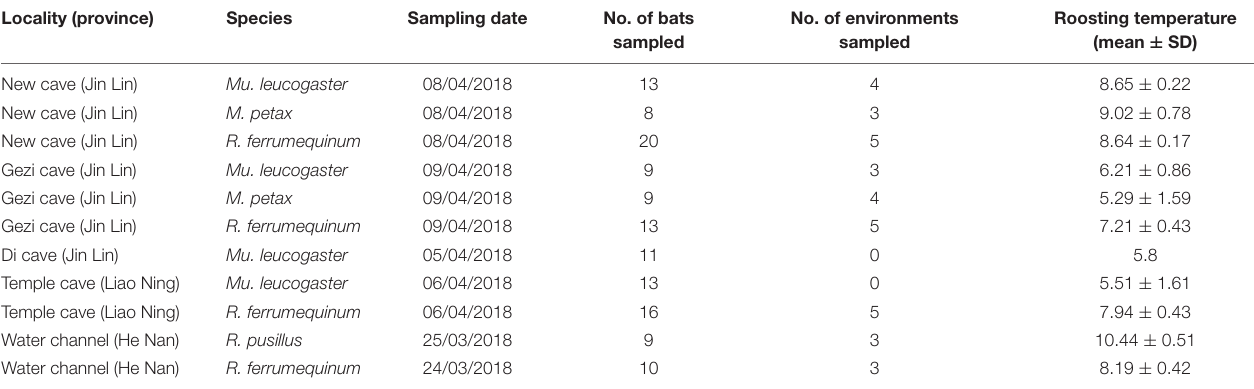
TABLE 1 | Summary of host species, site, and sample sizes information. Locality (province) Species Sampling date No. of bats